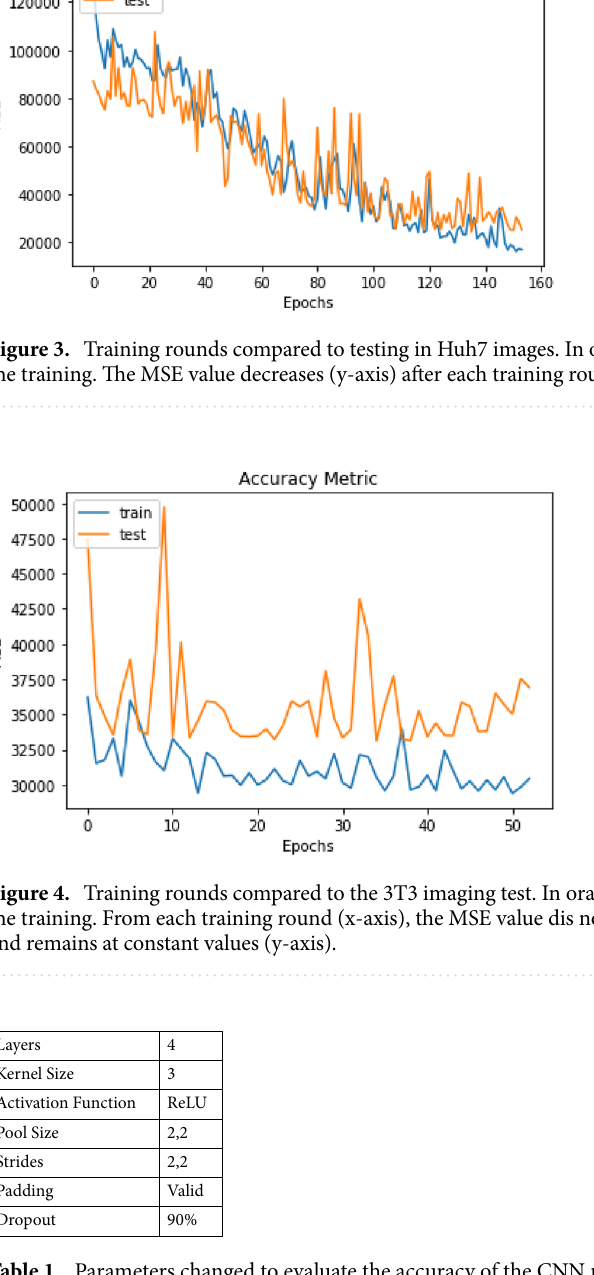
Table 1. Parameters changed to evaluate the accuracy of the CNN model.